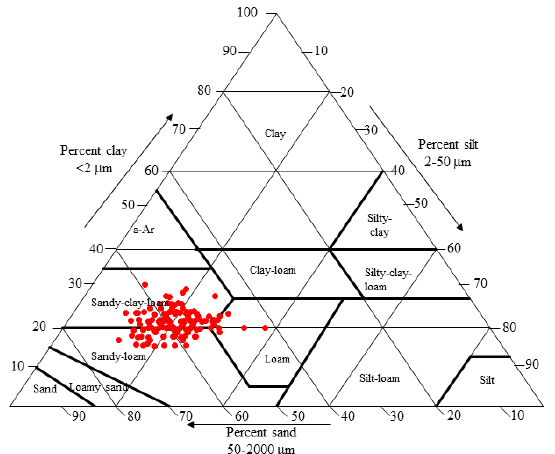
Figure 2. Soil textural triangle displaying each sample (red dots) from the experimental vineyard. The triangle shows the textural classification of the International Union of Soil Sciences [19].